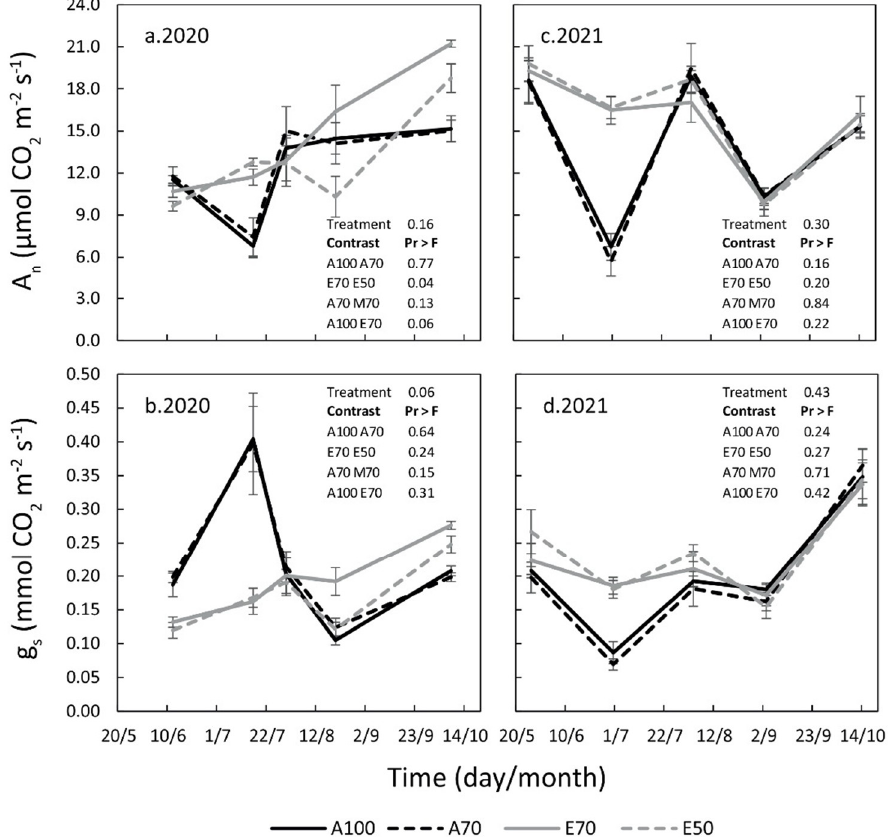
Figure 5. Seasonal patterns of midday leaf photosynthesis and stomatal conductance, throughout 2020 ( a , b ) and 2021 ( c , d ), for each treatment, represented by the mean value of four trees. Vertical bars represent standard error values. For each year, the effect of the treatment and linear contrast F values are shown and refer to the mean midday seasonal value of A n or g s ; values below 0.05 are considered significant.